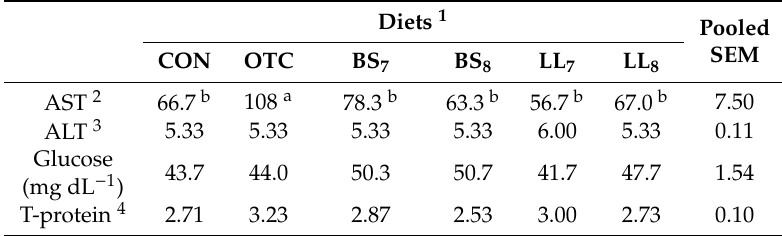
Table 6. Haematological analysis of juvenile Nile tilapia fed the experimental diets for 8 weeks.